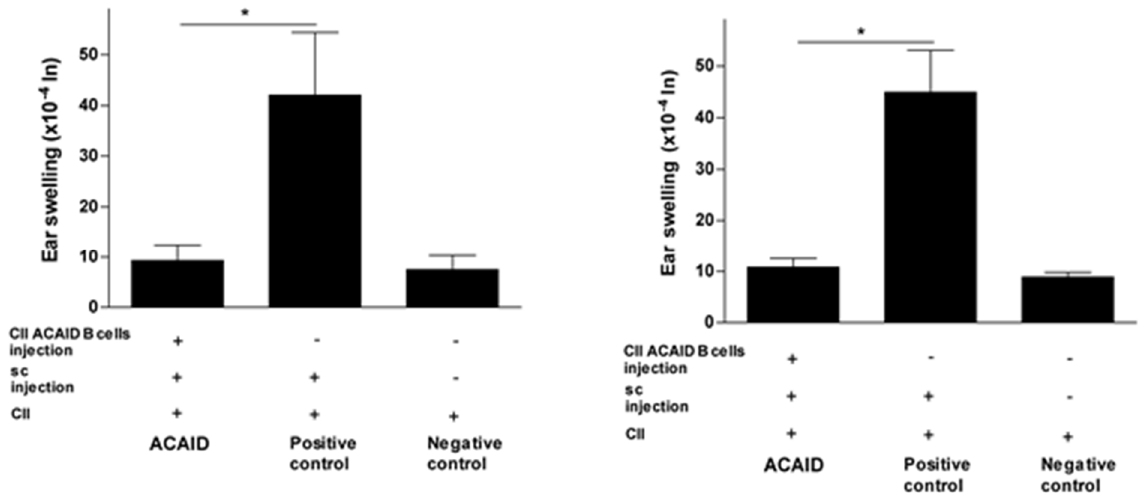
Figure 2. In vitro generated CII-specific ACAID B cells inhibited CII-induced DTH responses in C57BL/6 mice. The in vitro generation of CII-specific ACAID B cells and the DTH assay were described in the Materials and Methods section. CII-specific ACAID B cells were intravenously injected to induce ACAID followed by subcutaneous immunization with CII/CFA on day 7. On day 14, mice were challenged with CII (500 µg in 20 µL) intradermally in the left ear pinna, and 20 µL of acetic acid alone was injected into the right ear pinna as an internal control. ACAID induction was confirmed by suppression of ear swelling responses after 24 h (left panel) and 48 h (right panel). The positive control mice were subcutaneously immunized with CII/CFA on day 7 and with CII on day 14, whereas the negative control mice only received intradermal injection of CII on day 14. * p < 0.05 were considered to be statistically significant.